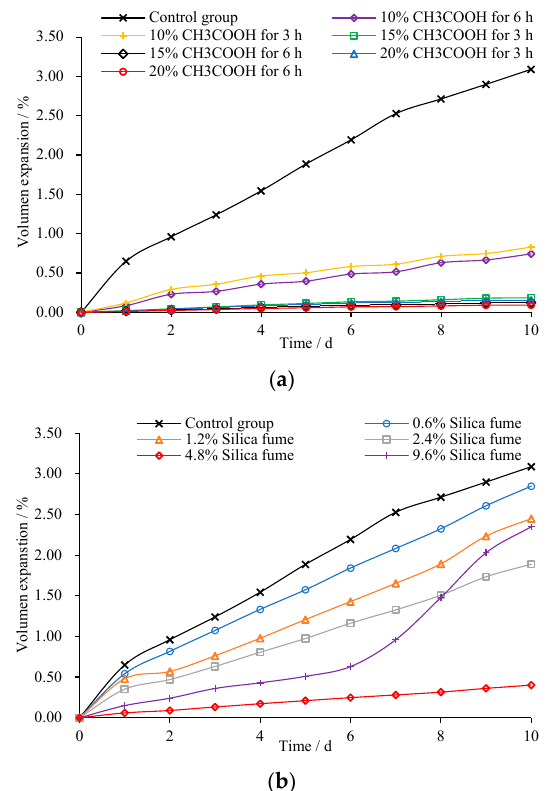
Figure 11. Volume stability results. ( a ) Treated with CH3COOH; ( b ) Addition of silica